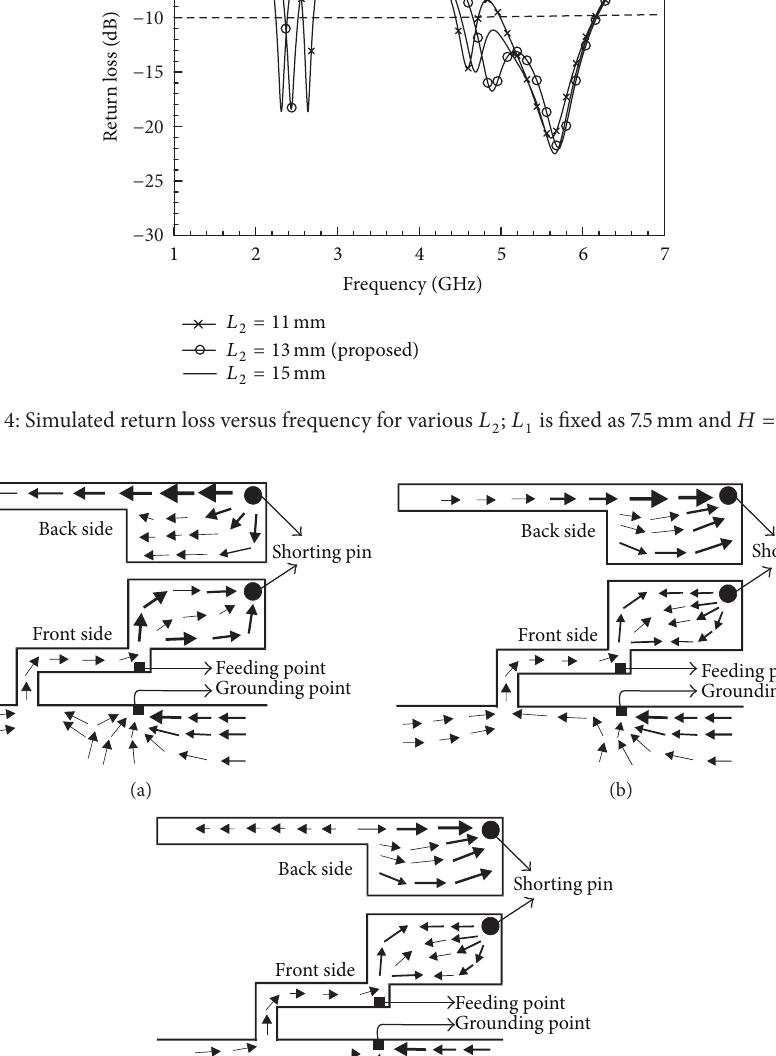
at higher frequency band. For the folded-coupling region of = 7.5 mm, the coupling effect 𝐻 = 1 mm and 𝐿 1